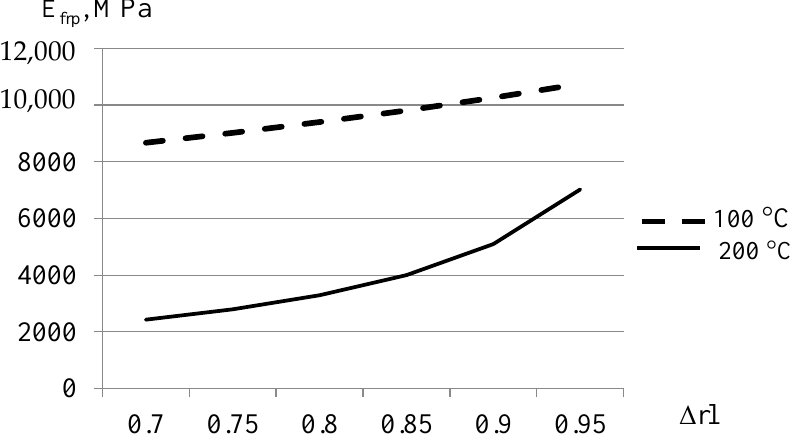
Figure 14. Dependence of elastic modulus of heat-treated fiberglass plastic on the proportion of reinforced layers in the thickness of the plastic at 100 °C and 200 °C.